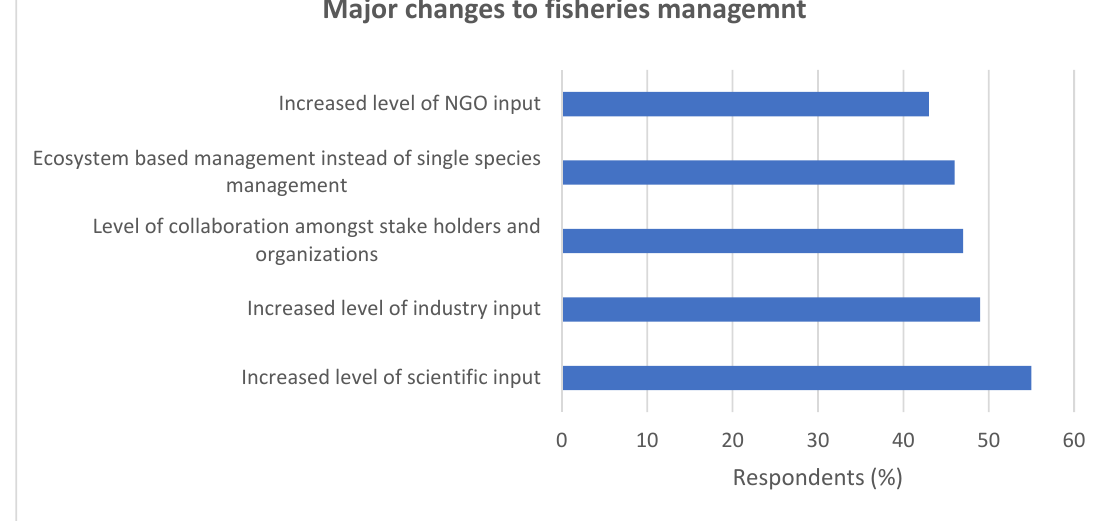
Figure 8. Major changes that have occurred in fisheries management during the respondents’ careers in fisheries (n = 109).